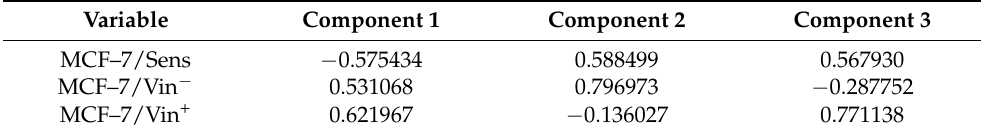
Table 3. Eigenvectors of the components from response